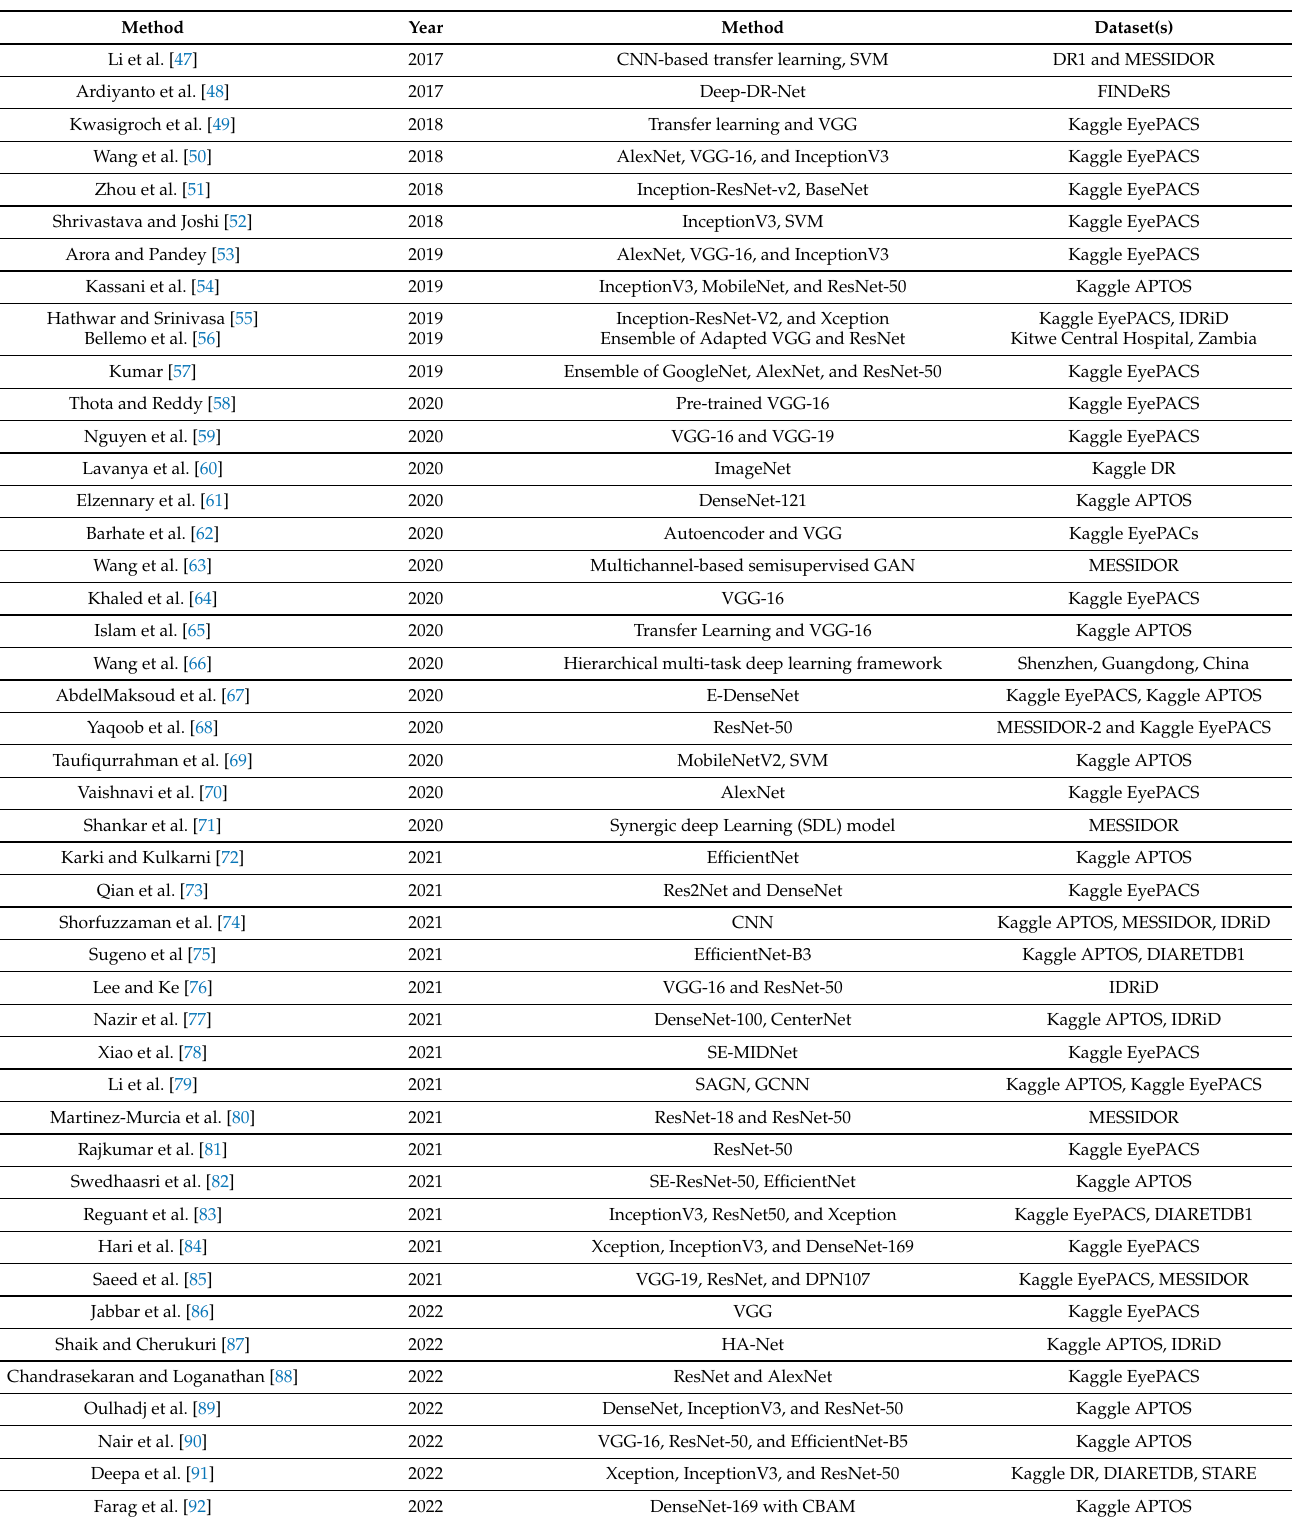
Table 1. Retinopathy-grading-based studies during the period